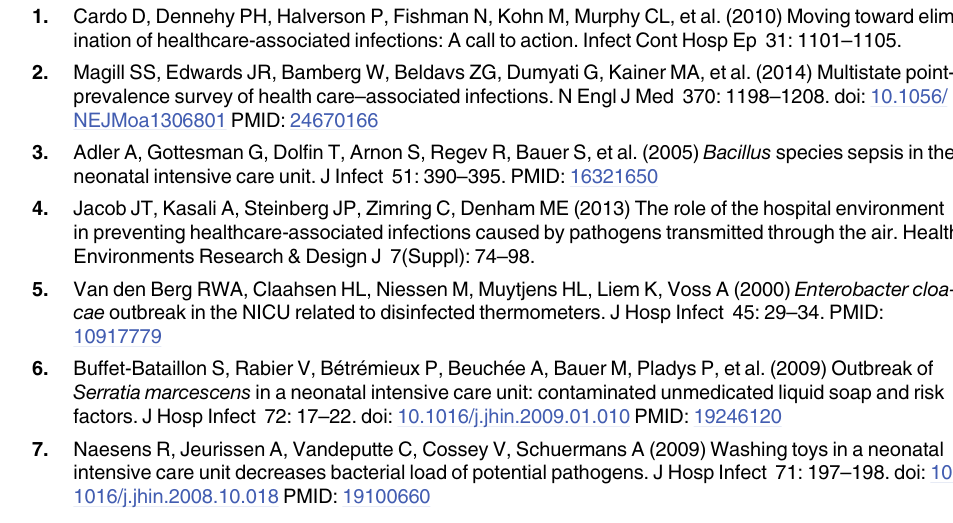
S2 Table. Size-resolved particle number concentrations measured in the baby rooms and hallway. The results include data from nurses ’ station (for B1, B2 and the first week of B3) and HVAC filter maintenance (no